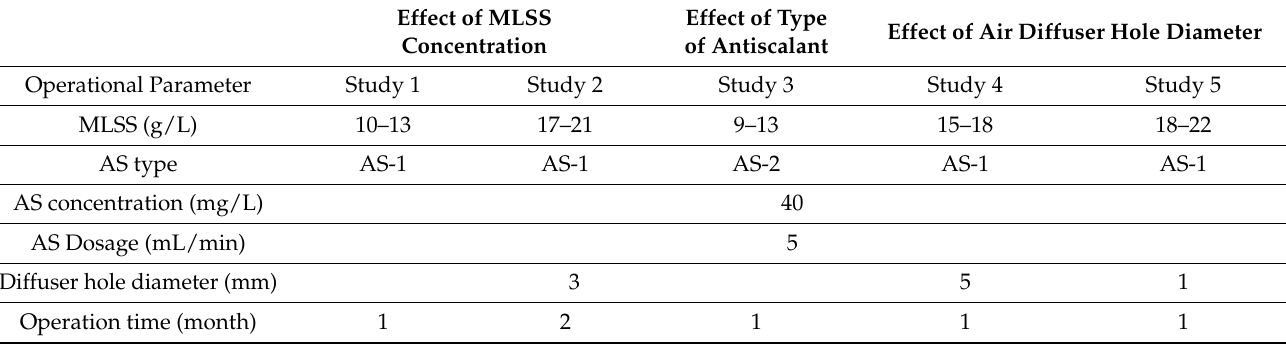
Table 3. Experimental test conditions employed in the pilot-scale MBR